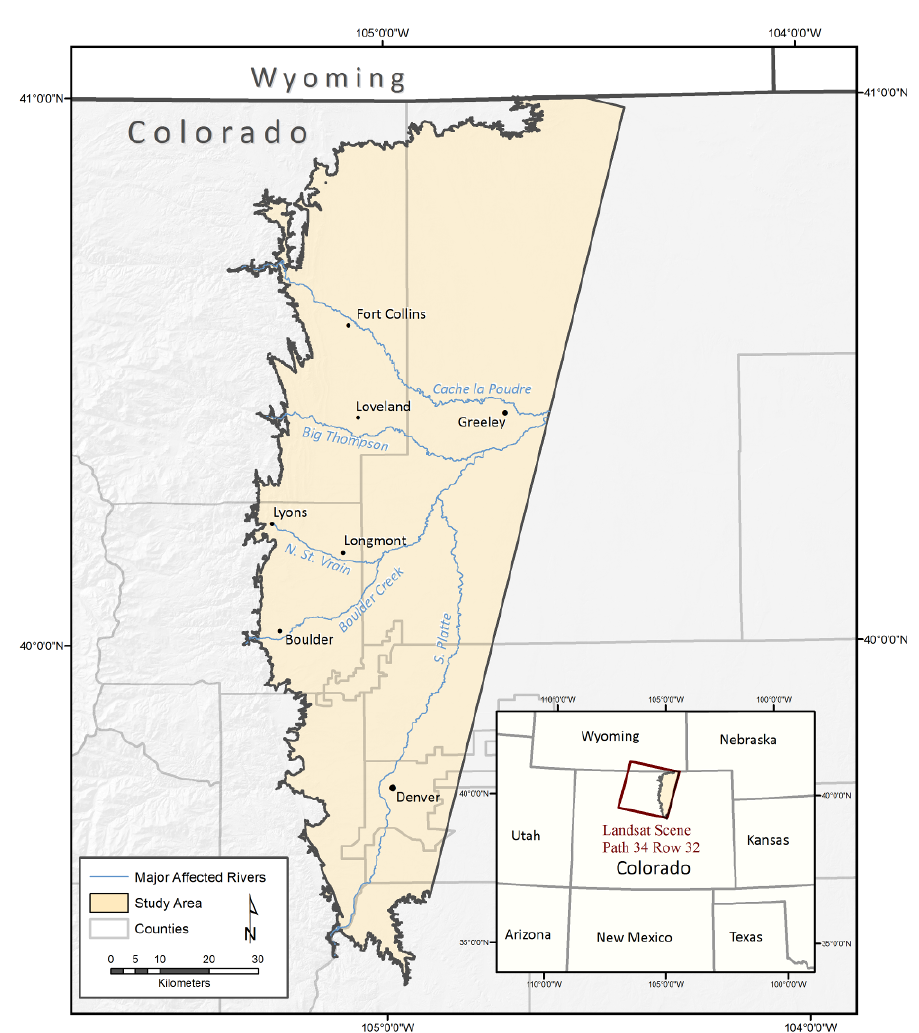
Figure 1. Map of the Colorado Front Range and the project study site, comprised of all areas within WRS-2 Path 34, Row 32 below 1800 m in elevation. Major affected counties, cities, and rivers are included for